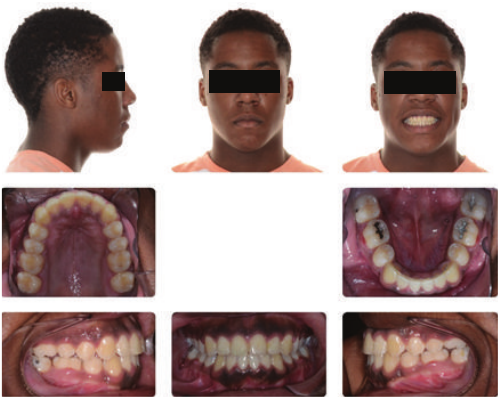
Figure 16: Stage 2: Orthodontic Treatment Final Composite.